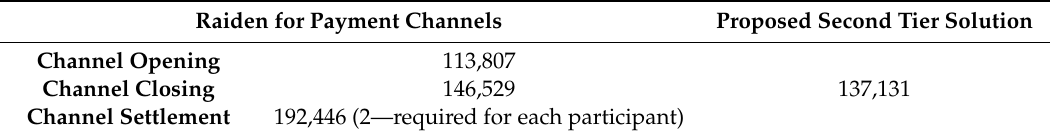
Table 4. Energy transaction processing costs in gas: Payment channels vs our second tier